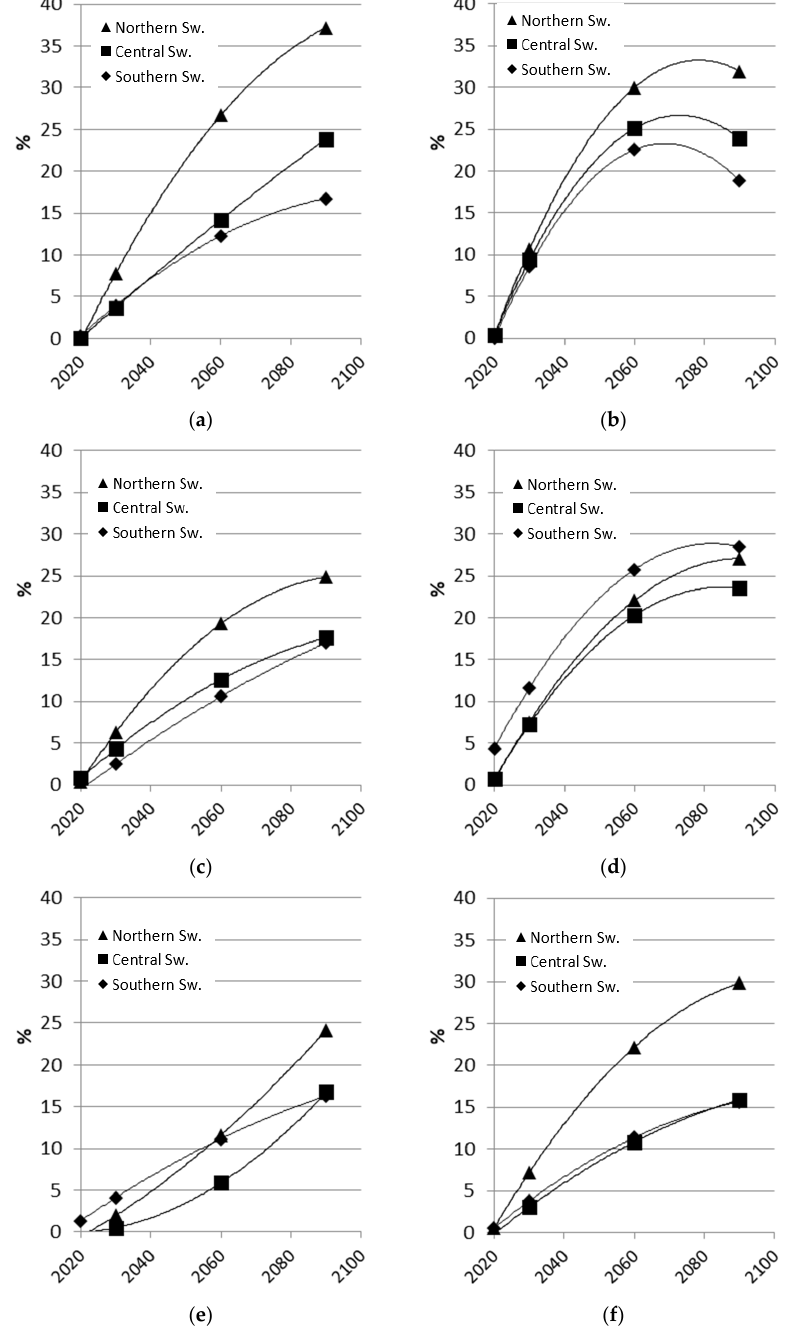
Figure 2. Relative change of production (%) for B2 and A2 scenarios for spruce, pine, and deciduous species for the period 2015 − 2090: ( a , b ) refer to Norway spruce, ( c , d ) to Scots pine, ( e , f ) to deciduous species; ( a , c , e ) to climate scenario B2, and ( b , d , f ) to climate scenario A2; Northern Sweden (<59 (cid:48) N), central (59 − 63 (cid:48) N), and northern (>63 (cid:48) N)